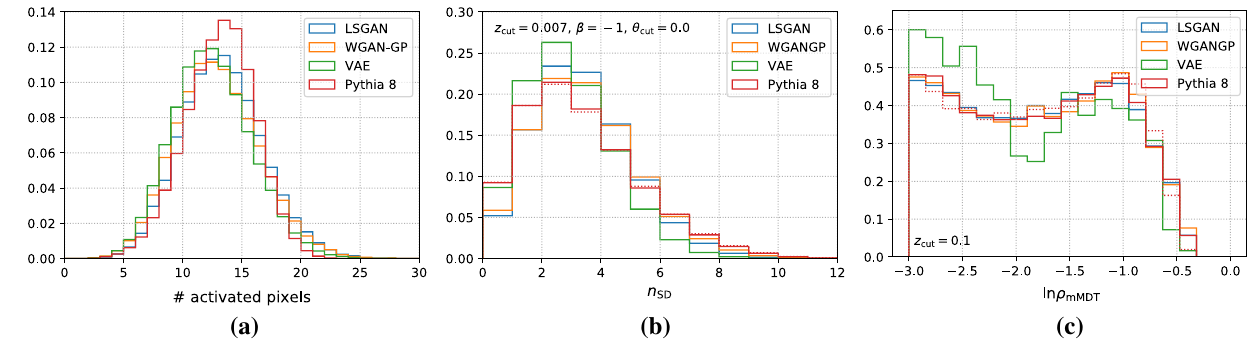
Fig. 10 Distribution of a the number of activated pixels per image, b the reconstructed soft-drop multiplicity for z cut = 0 . 007, β = − 1 and θ = 0, and c the jet mass after applying the modified Mass Drop Tagger with z cut